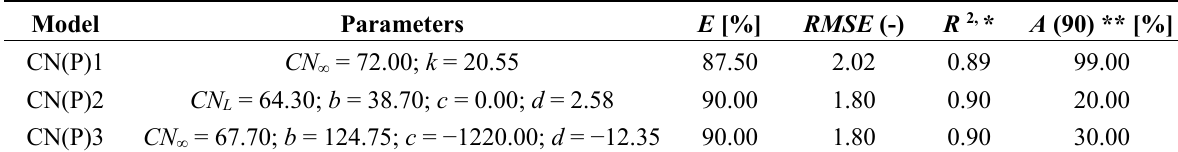
Table 6. P - CN obs parameters of different models and the quality of calculation-observation fit in the watershed